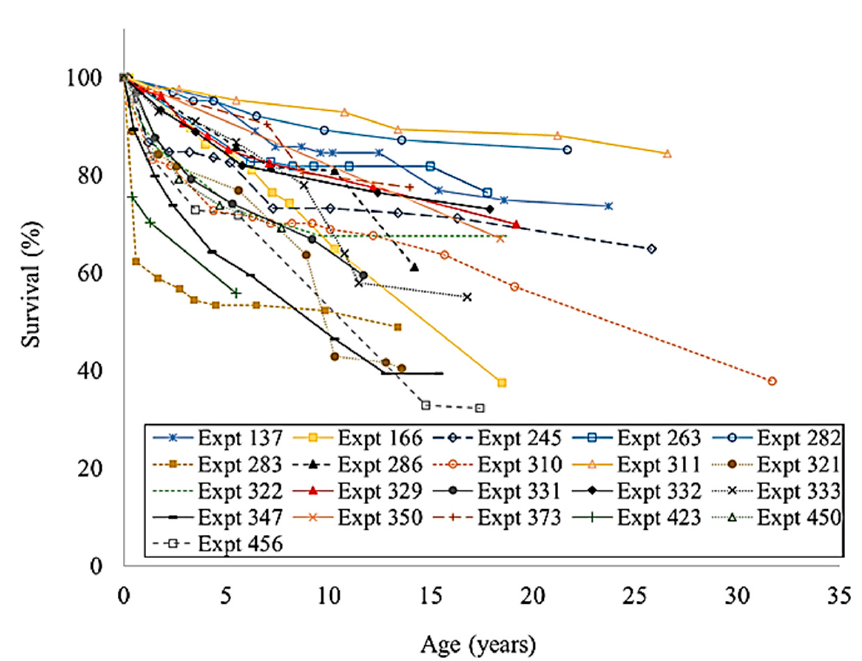
Figure 1. The survival of Flindersia brayleyana in enrichment planting experiments at di ff erent sites in north Queensland.